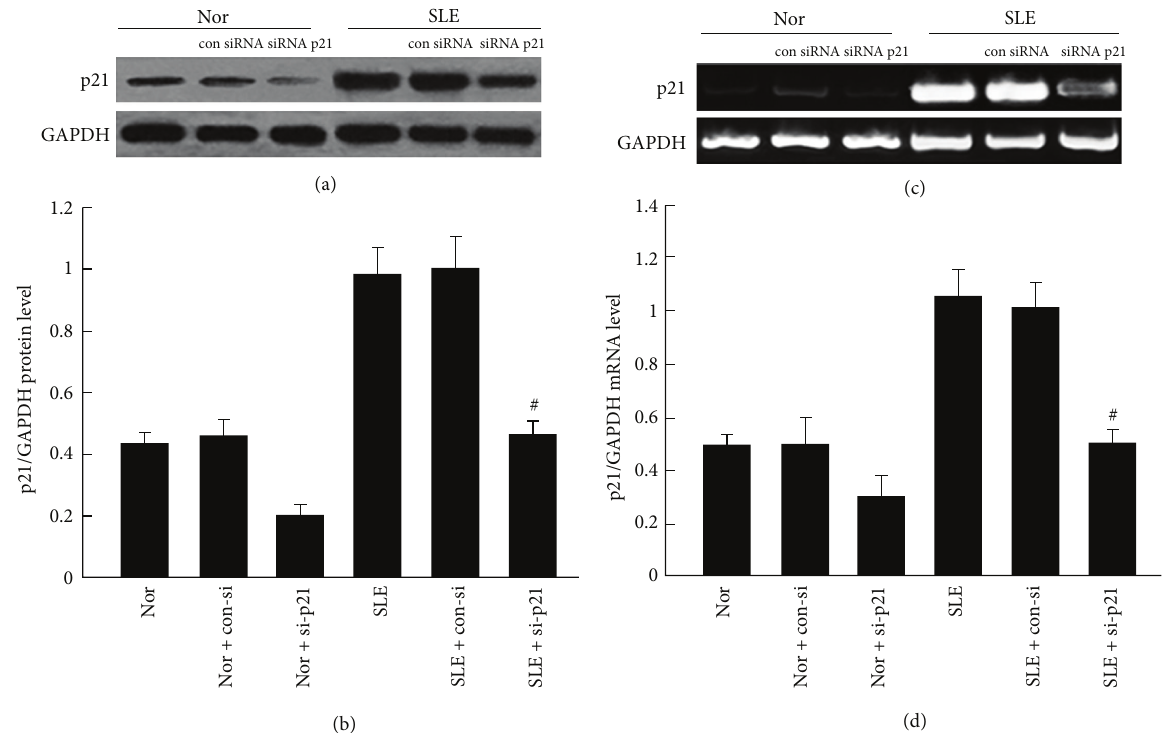
Figure 5: p21 siRNA decreased p21 expression in BM-MSCs. Cells were transfected with p21 siRNA for 24 hours. p21 expression was significantly decreased in BM-MSCs both in SLE patients and normal control by immunoblot analyses ((a)-(b)) and RT-PCR ((c)-(d)). The relative levels of protein expressions and gene expression of target mRNA were normalized to GAPDH expression. Values are means ± SD of three experiments ( # 𝑃 < 0.05